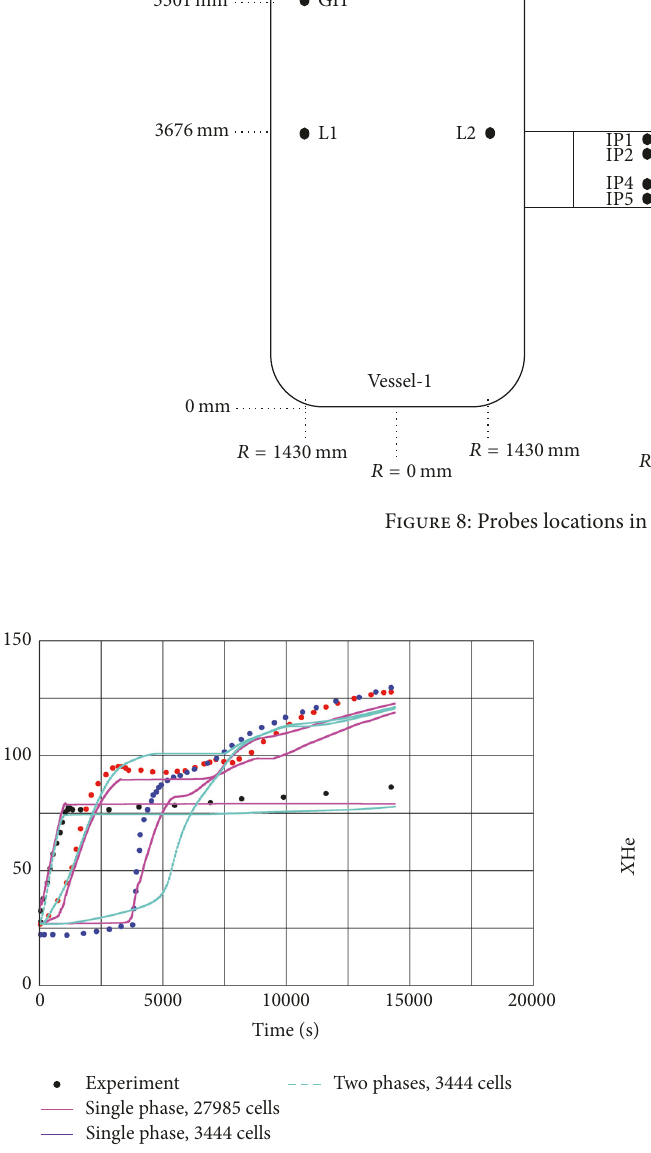
Figure 9: Vessel temperature evolutions at 3 locations: top (black points), middle (red points), and bottom (blue points); “single phase” stands for Code Saturne and “two phases” stands for NEPTUNE CFD code.